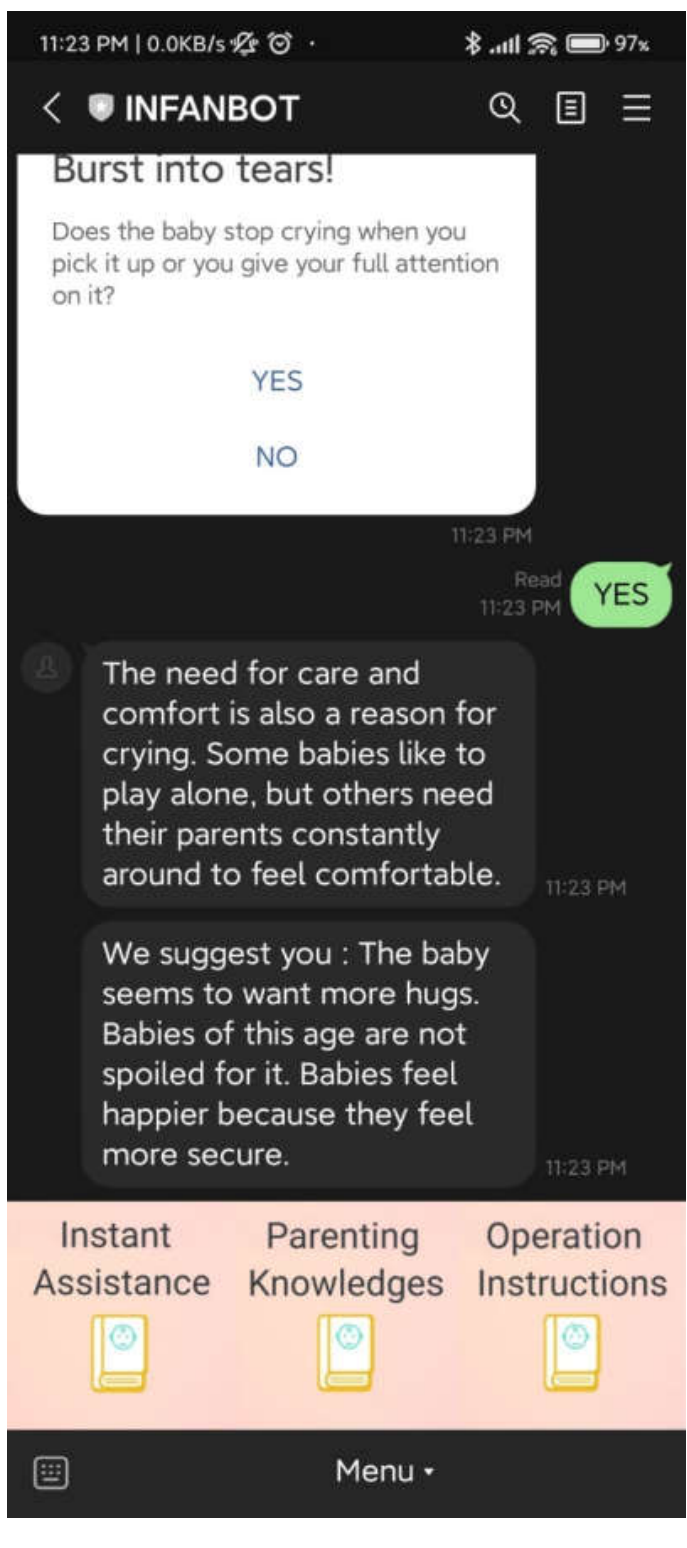
Figure 7. The possible reason and the way to deal with it.